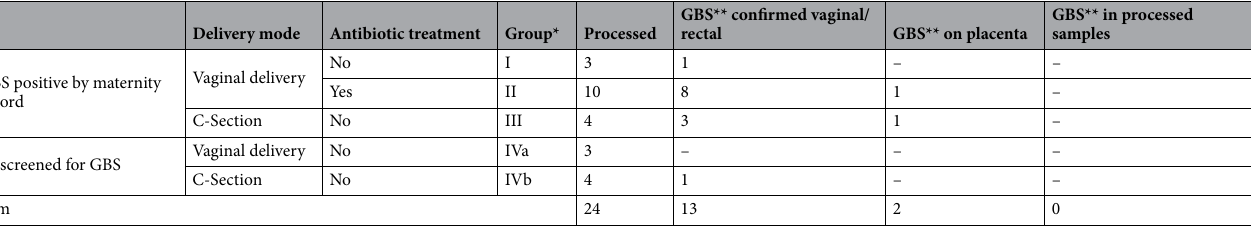
Table 1. Baseline data and results according to GBS-status (maternity record) and delivery mode and antibiotic treatment. *Group I: GBS positive, vaginal delivery, no antibiotic treatment, (II) GBS positive,